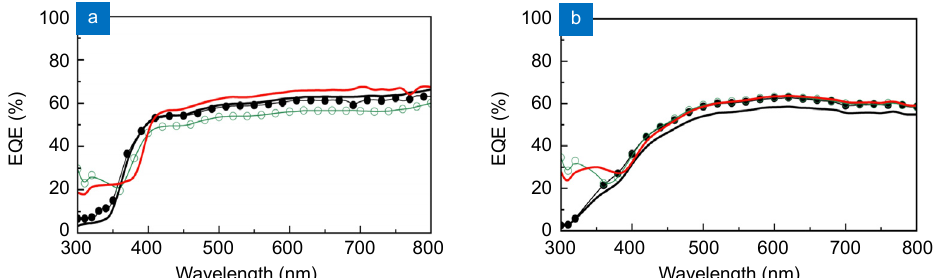
Fig. 3 | Total (solid lines) and diffuse (dashed lines) reflectance of (a) PV-1 and (b) PV-2 with dU6-Tb (green lines) and tU5-Eu (red lines) coatings compared with the average reflectance curve measured for distinct bare PV devices (black lines).